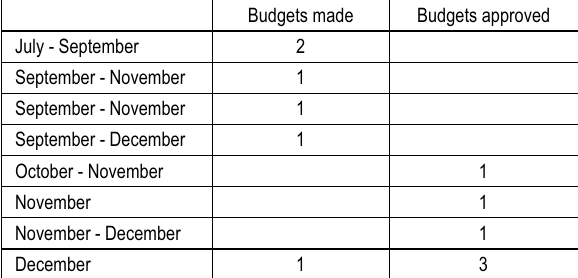
Table 9. Answer to the question: time of year X